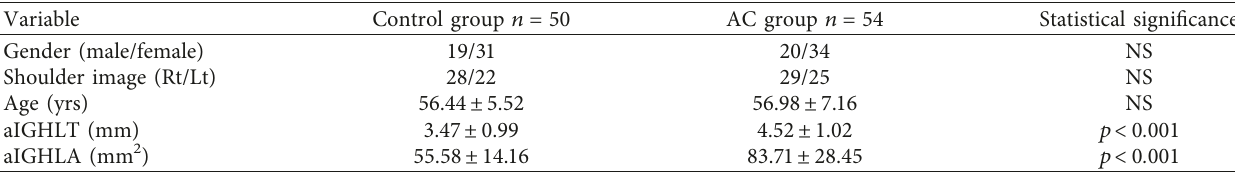
Table 1: Comparison of the characteristics of control and AC